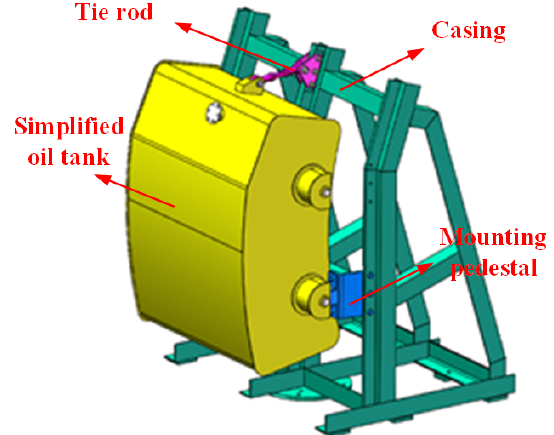
Figure 1. Simplified lubricating oil tank model supported by multiple mounting